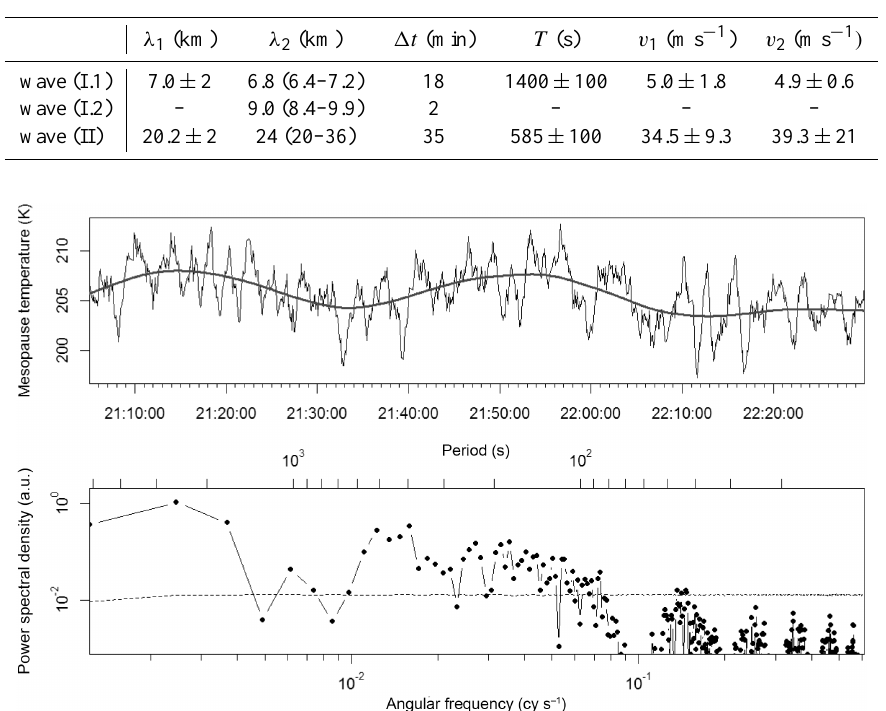
Table 1. Summary of the determined wave parameters identified in Fig. 9. Wave structure (I) is separated into (I.1), lasting until 21:54UTC and (I.2), emerging at 21:54UTC. λ is the horizontal wavelength once determined in position space λ 1 (see Fig. 9a and b), once in frequency domain λ 2 (Fig. 9c and d). (cid:49)t is the lifetime determined in the frequency domain (Fig. 9c and d), T is the wave period (determined from Fig. 9a and b) and v the horizontal phase velocity referring to λ 1 and λ 2 .